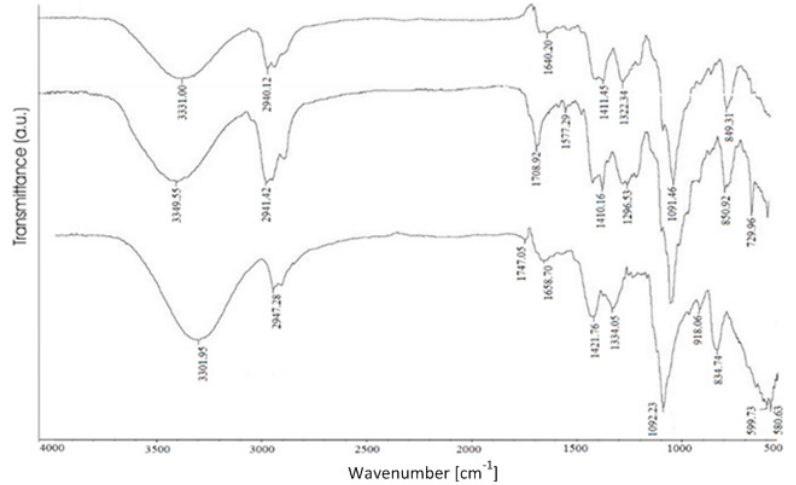
Figure 4. FTIR spectra for PVA-BC 12/6 ( top ), PVA-BC 12/12 ( middle ) and PVA-BC 12/18 ( bellow ) composite membranes after preparing and drying at 90 °C.